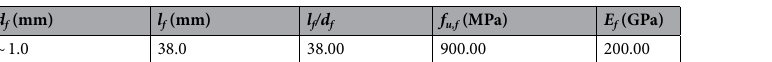
Table 2. Mechanical properties of crimped steel fibers. d f = equivalent diameter of fiber; l f = fiber length; l f / d f = aspect ratio; f u,f = ultimate tensile strength of fiber; and E f = elastic modulus of fiber.